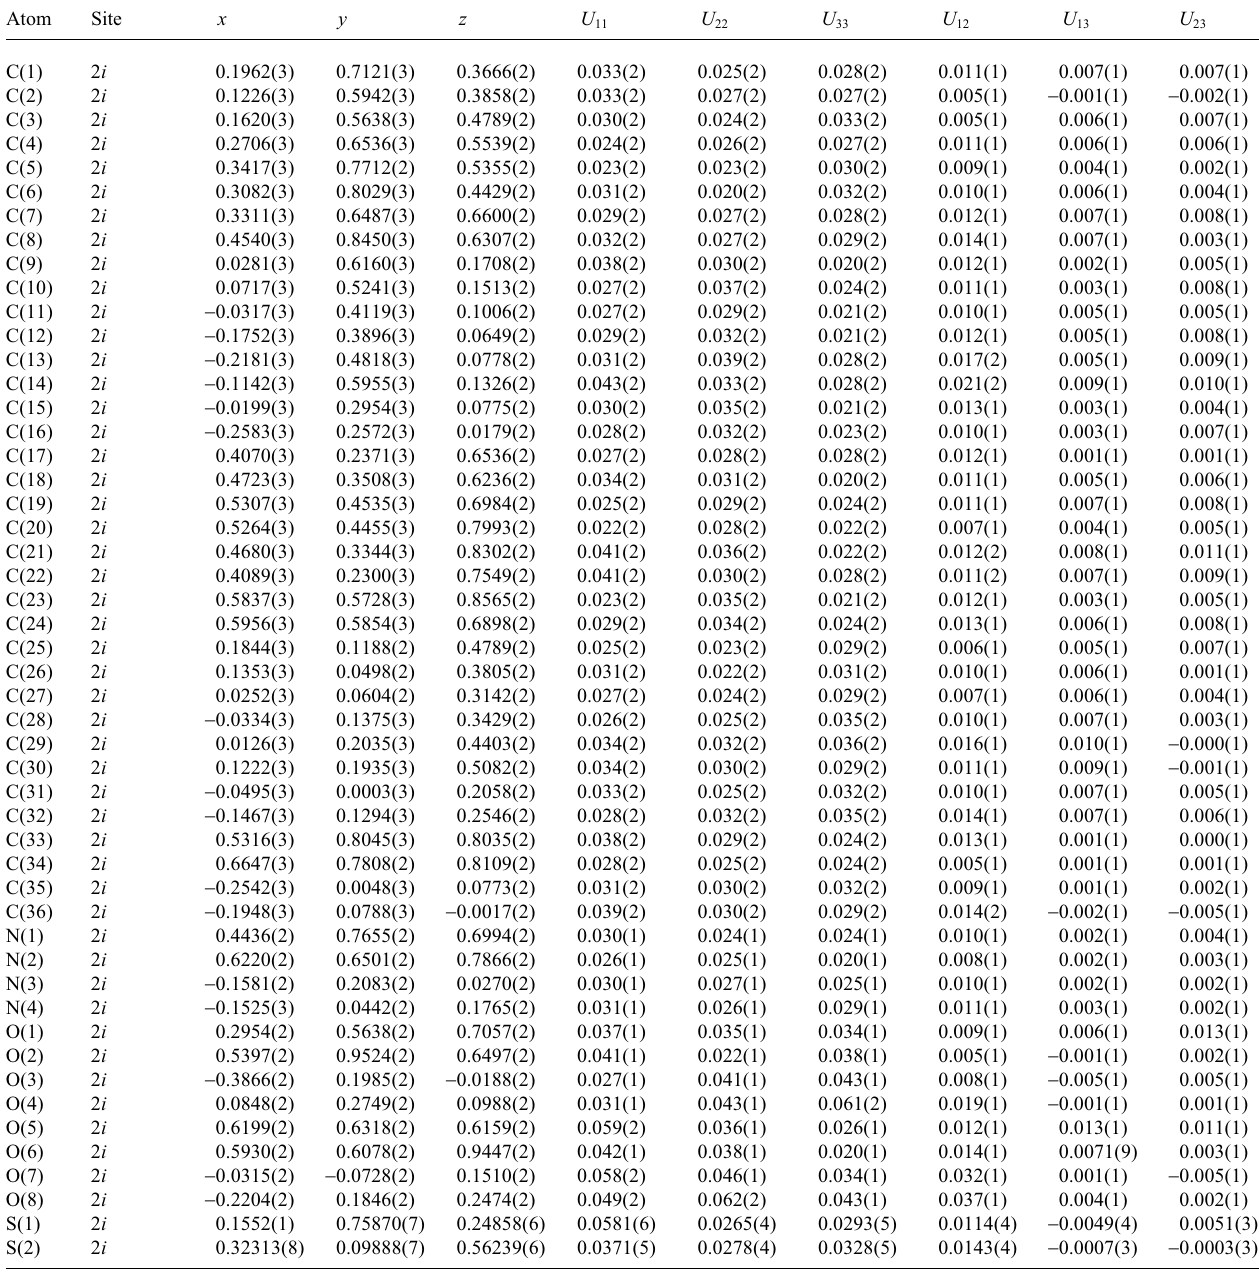
Table 3. Atomic coordinates and displacement parameters (in Å 2 )